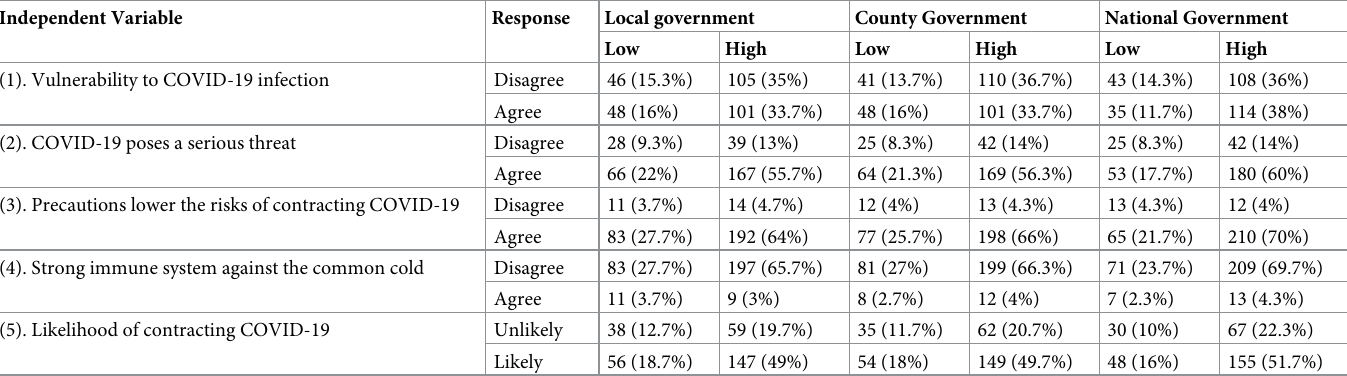
Table 8. COVID-19 perceived risks among self-confirmed CHVs n = 300 (frequencies).